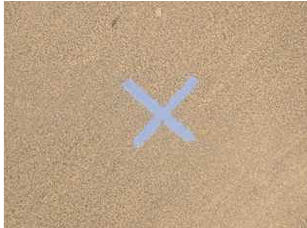
Figure 6. Calibration points (width approximately 10 cm) on the bridge deck used to calibrate the